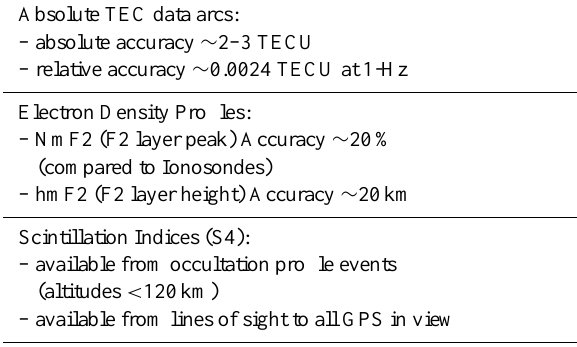
Table 3. Space weather products produced by